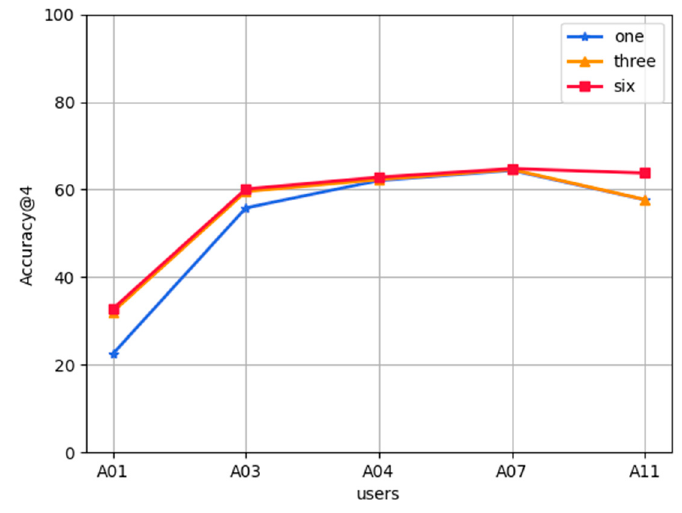
Figure 10. Effect of historical data on FL-AHNEAP.